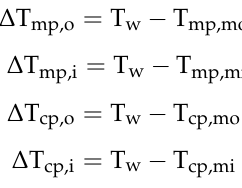
Figure 2. ( a ) Main pipe (mp) passing through the hot water and ( b ) connecting pipe (cp) that connects the main pipe with the AGMD module.